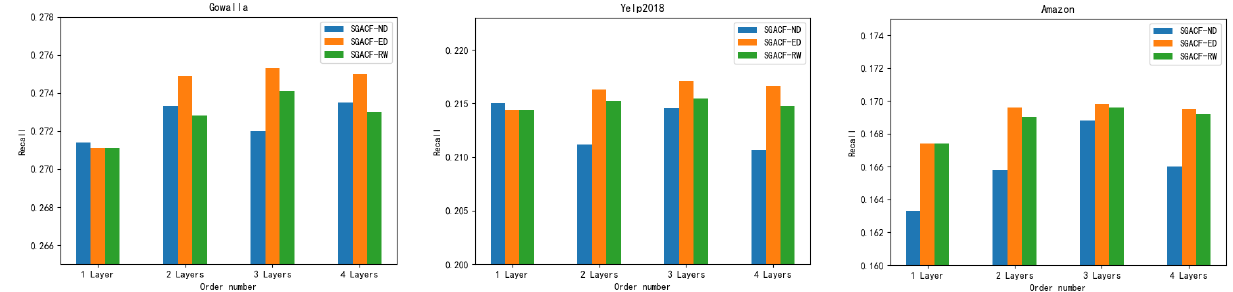
Figure 4. Impact of order and graph augmentation on performance.